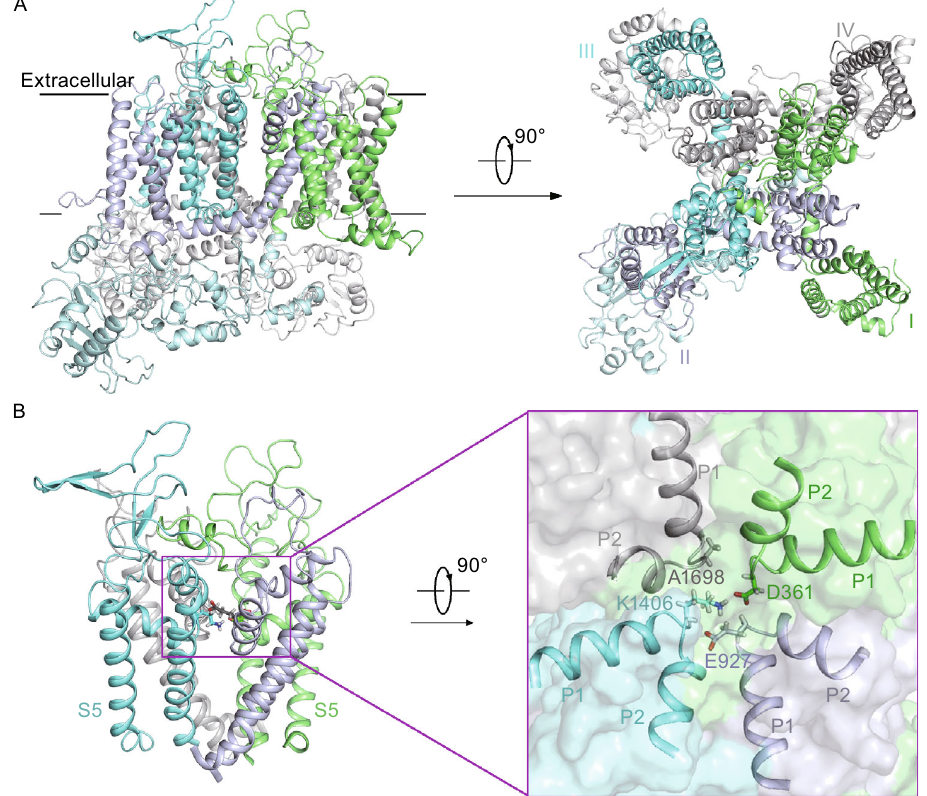
Figure 1. Homology model structure of human Na v 1.7 sodium channel. (A) Intra-membrane view and extracellular view of the structure model of Na v 1.7. The four domains are colored green, light blue, cyan, and gray for domain I, II, III, and IV, respectively. (B) The pore domain of Na v 1.7 structure model. The S5 – S6 segments of Na v 1.7 are shown and the four selectivity fi lter amino acids are shown as sticks (left). A close-up view of the four SF residues, D361 in domain I, E927 in domain II, K1406 in domain III, and A1698 in domain